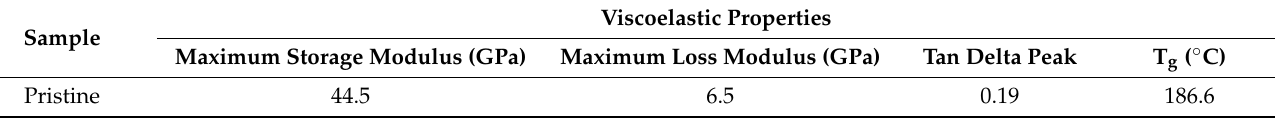
Table 2. Viscoelastic properties of pristine specimens made from epoxy-resin-based